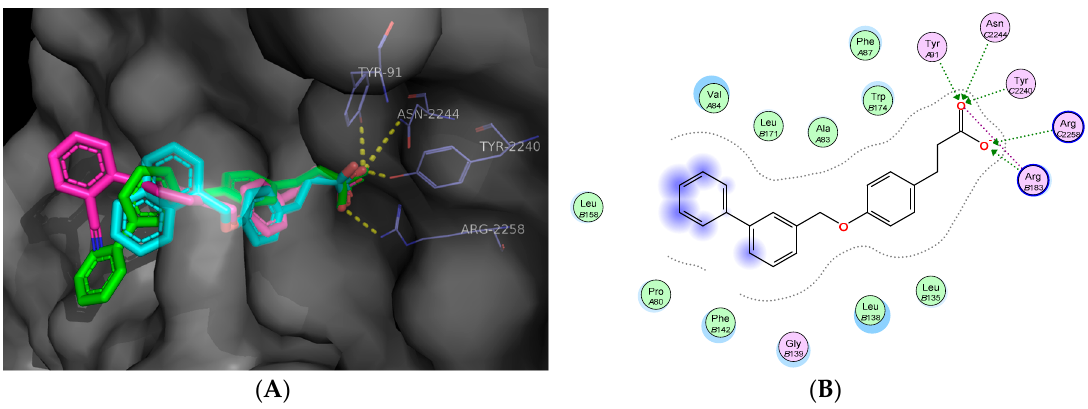
Figure 4. ( A ) 3D binding model of compounds 1 – 3 into the allosteric ligand binding site of GPR40. Compounds are presented as stick models: 1 (green), 2 (cyan) and 3 (magenta). ( B ) 2D interaction map of the most active compound 1 and GPR40.